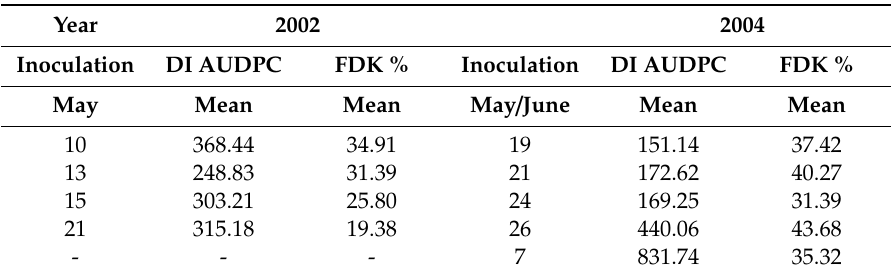
Table 4. FHB resistance test in wheat, AUDPC and FDK values in the Frontana / Remus mapping populations according to the inoculation dates, 2002 and 2004